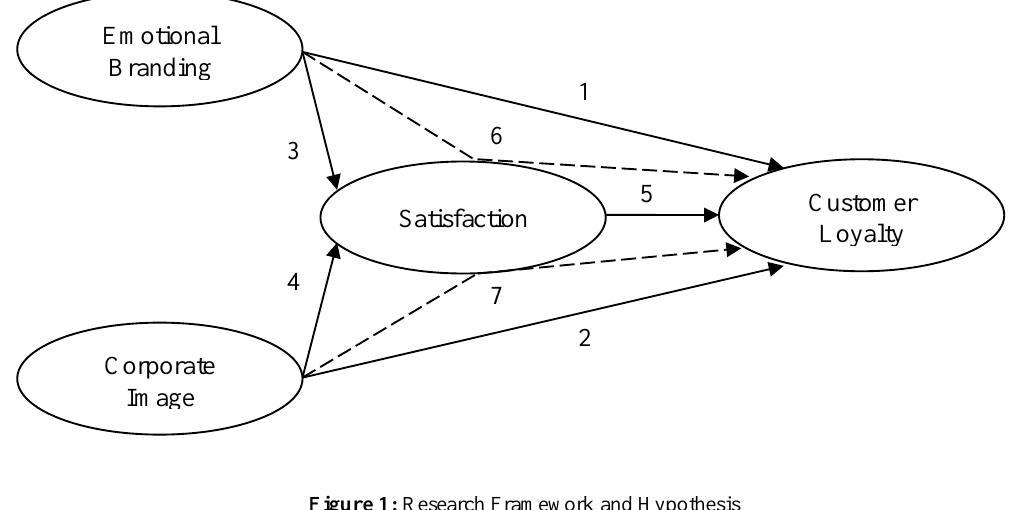
Figure 1: Research Framework and